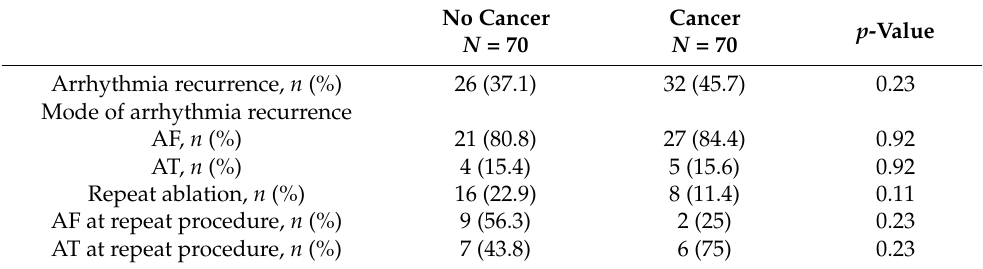
Table 3. Arrhythmia follow-up of patients with and without history of cancer.